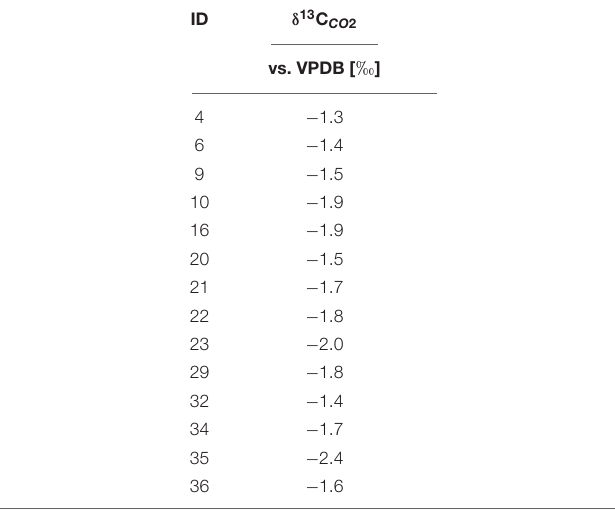
TABLE 2 | Carbon isotope composition of CO 2